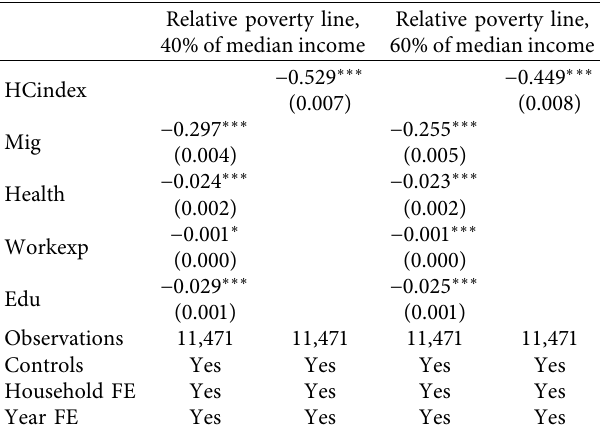
Table 7: Robustness